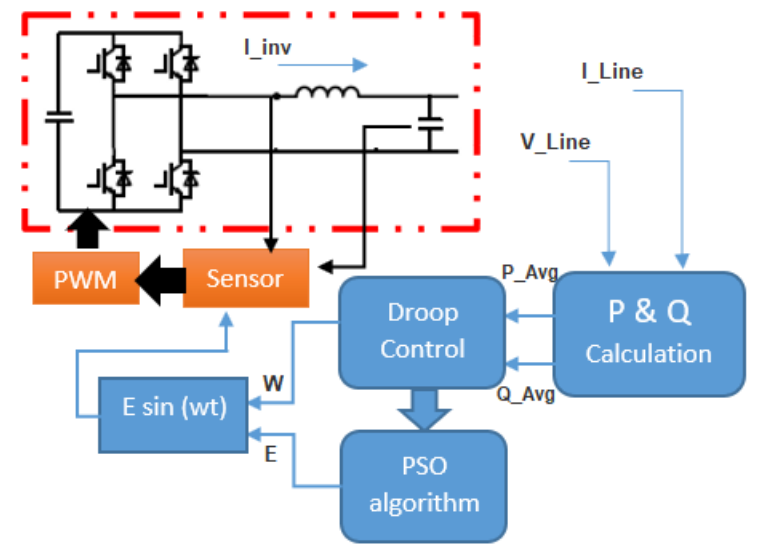
Figure 5. Scheme of the PSO droop control method.